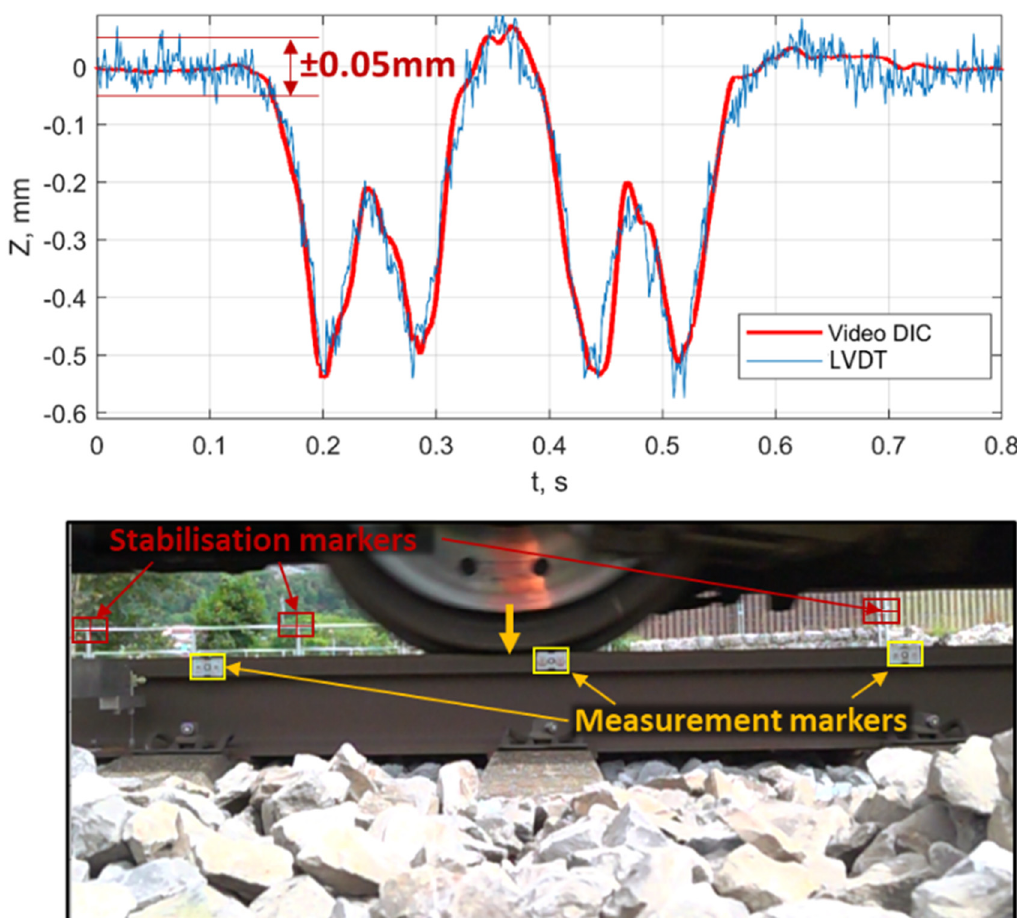
Figure 13. Rail deflection measurements using DIC method. ( top ) Comparing video DIC and LVDT methods. ( bottom ) Markers in the space between the wheelsets.